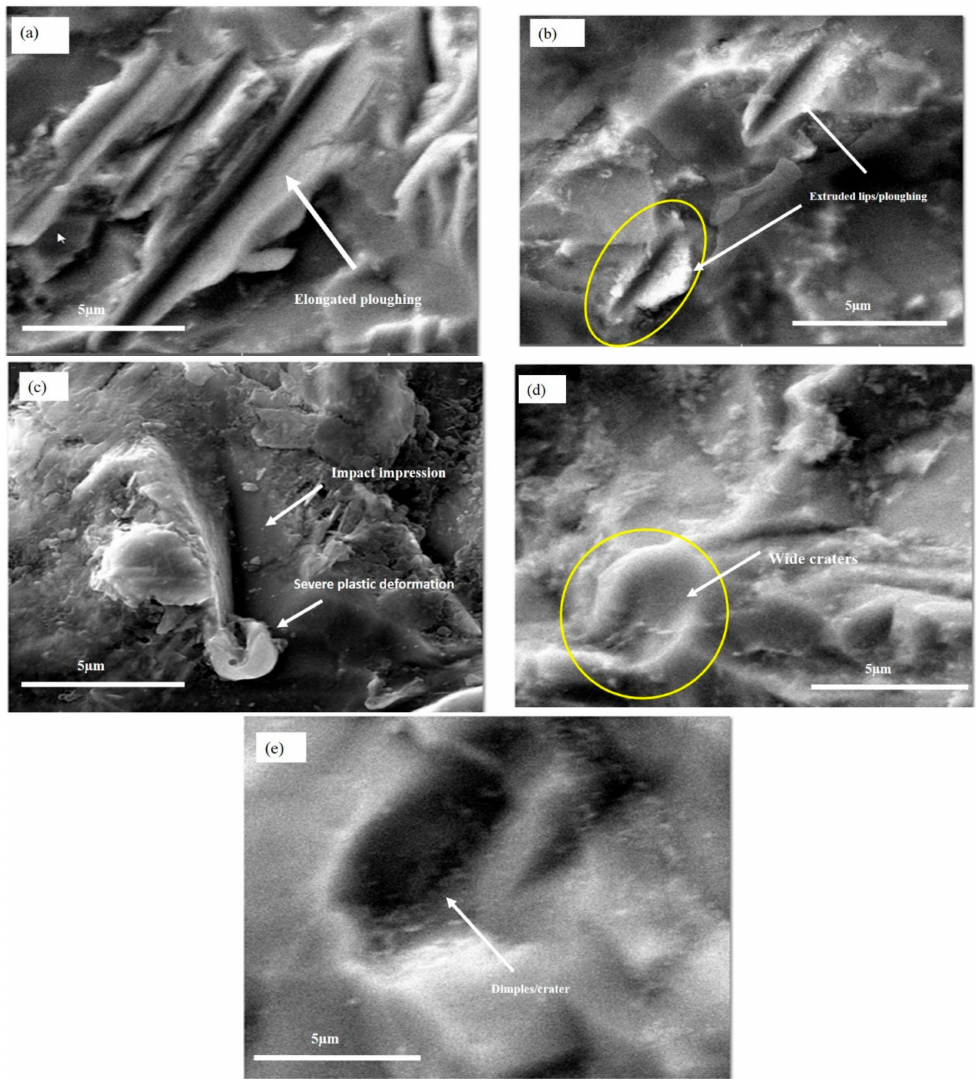
Figure 6. FE-SEM micrographs ( a – e ) showing different features of material removal during erosion corrosion